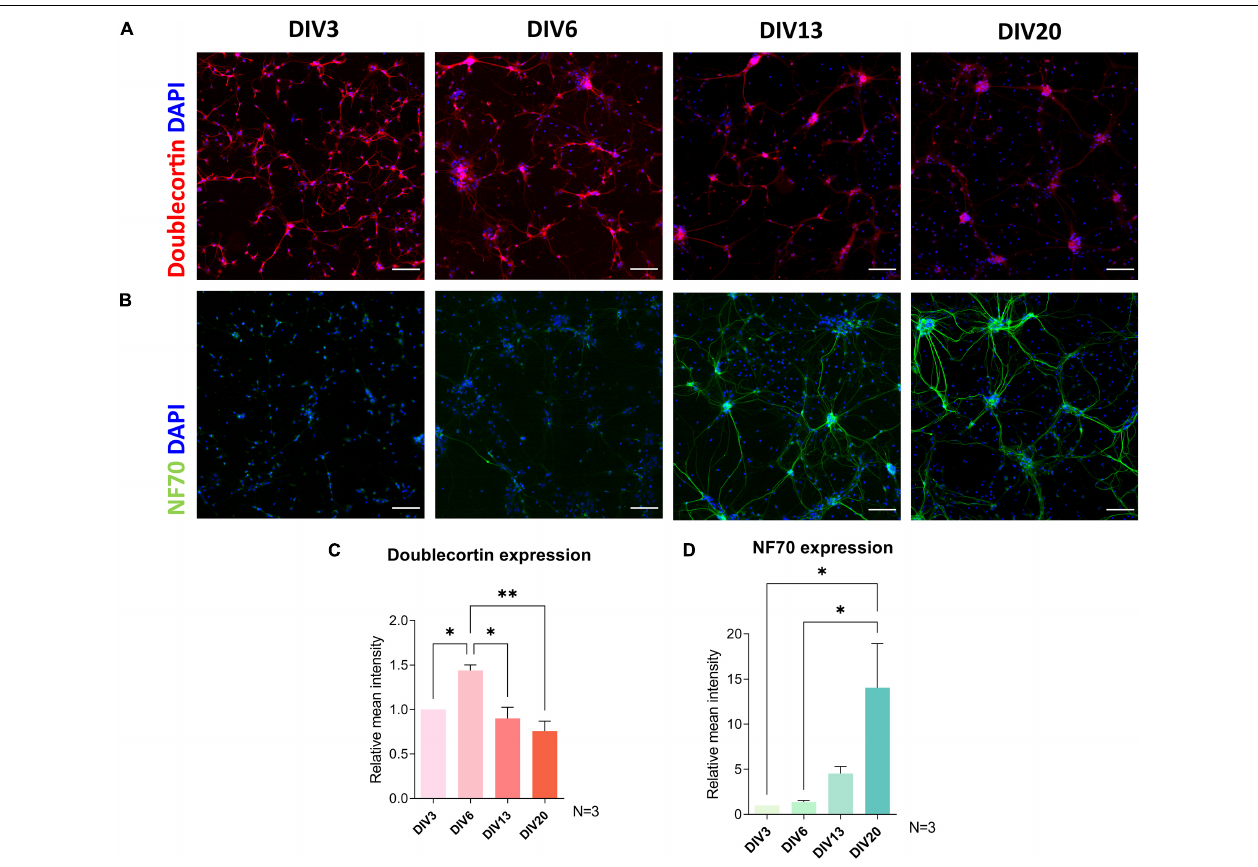
FIGURE 4 | Immunocytochemical analysis of maturity markers doublecortin (A,C) and neurofilament 70 kDa (NF70) (B,D) expression during cultivation. Doublecortin expression was downregulated after DIV6, while a significant increase in NF70 signal was observed after DIV13. Scale bars: 100 µ m. Data are presented as means + SEM of N = 3 biological replicate cultures; ∗ p < 0.05, ∗∗ p <